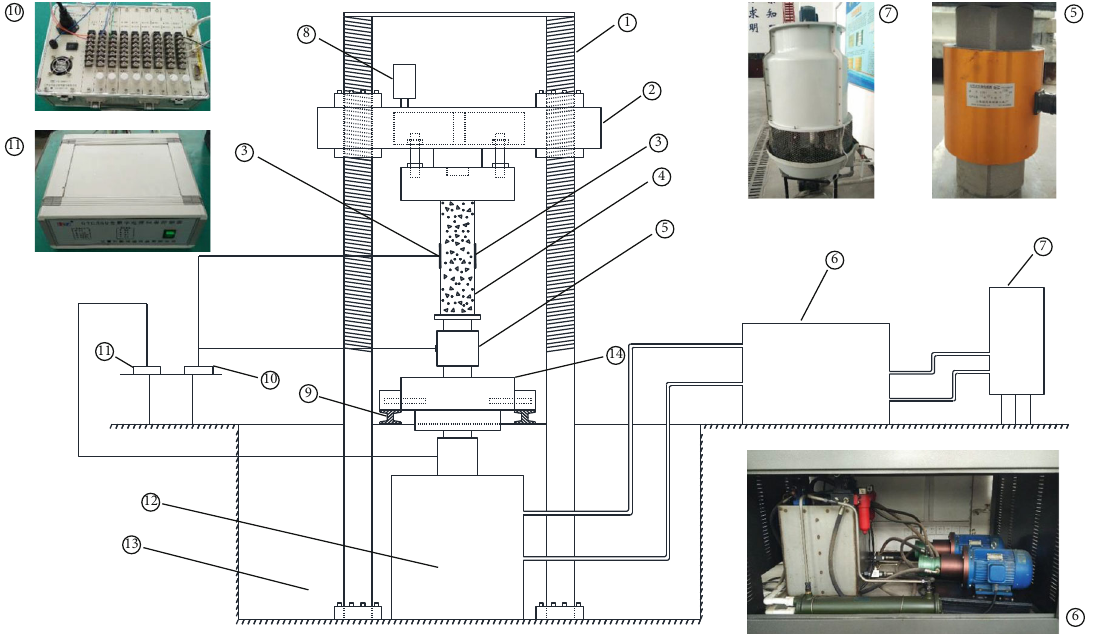
Figure 1: Electrohydraulic servo creep test system: ① Guide screw. ② Bearing plate. ③ Strain gauge. ④ Concrete. ⑤ Pressure transducer. ⑥ Oil pump system. ⑦ Cooling tower. ⑧ Electric machinery. ⑨ Track. ⑩ Strain collection device. ⑪ Controller. ⑫ Power device. ⑬ Underground space. ⑭ Bearing